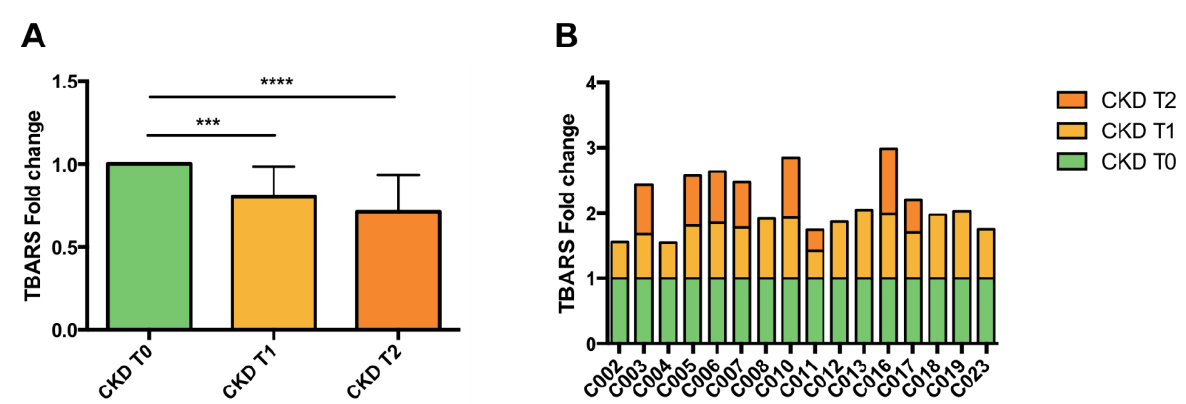
Figure 3. Curcumin supplementation decreases lipid peroxidation in plasma of CKD patients. ( A ) average values of lipid peroxidation (normalized to baseline values, CKD T0) after 3 months (CKD T1) and 6 months (CKD T2) supplementation. ( B ) Examples of intra-individual lipid peroxidation changes after Meriva ® supplementation; *** p < 0.001; **** p < 0.0001.